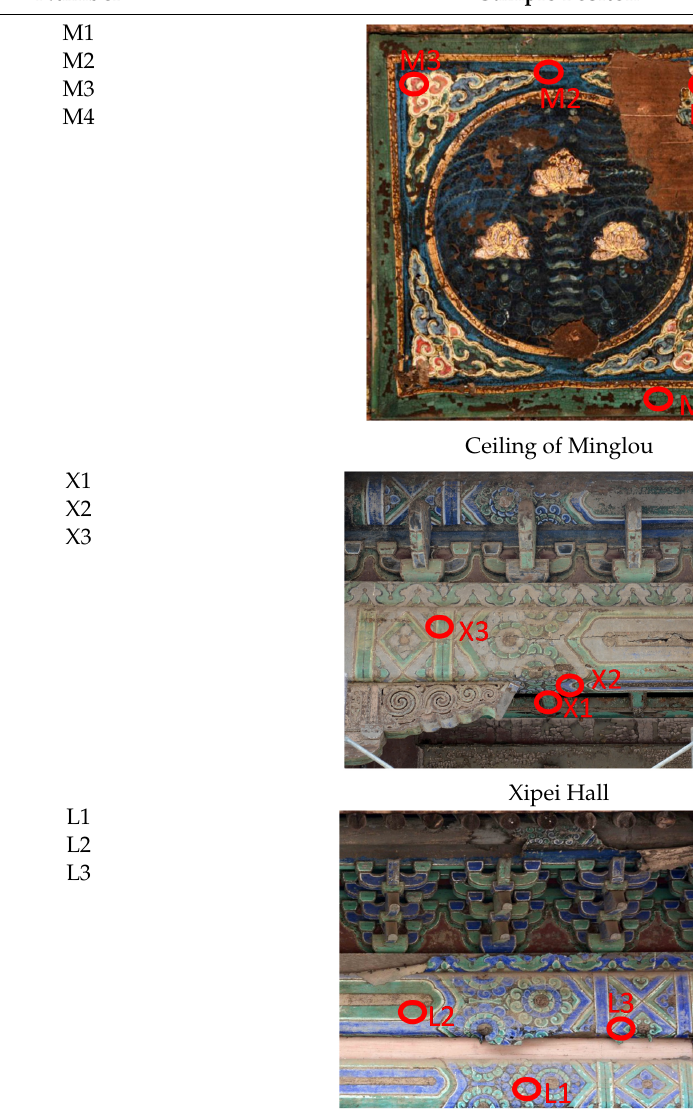
Table 1. Long’en Hall, Xipei Hall, ceiling of Minglou sampling location.